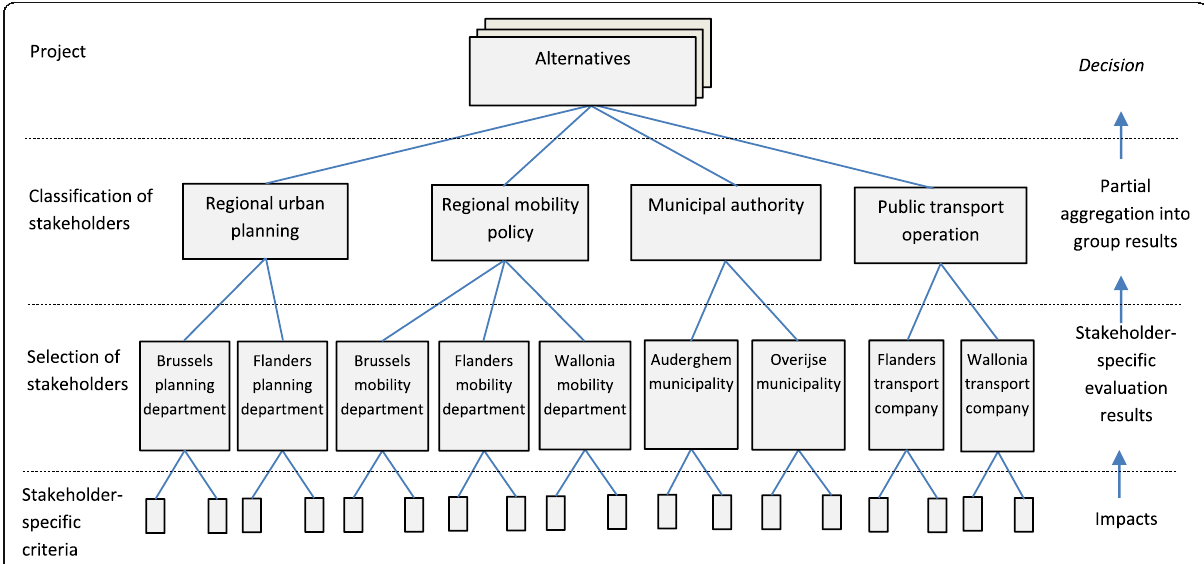
Fig. 7 Aggregation structure of the evaluation. Figure by